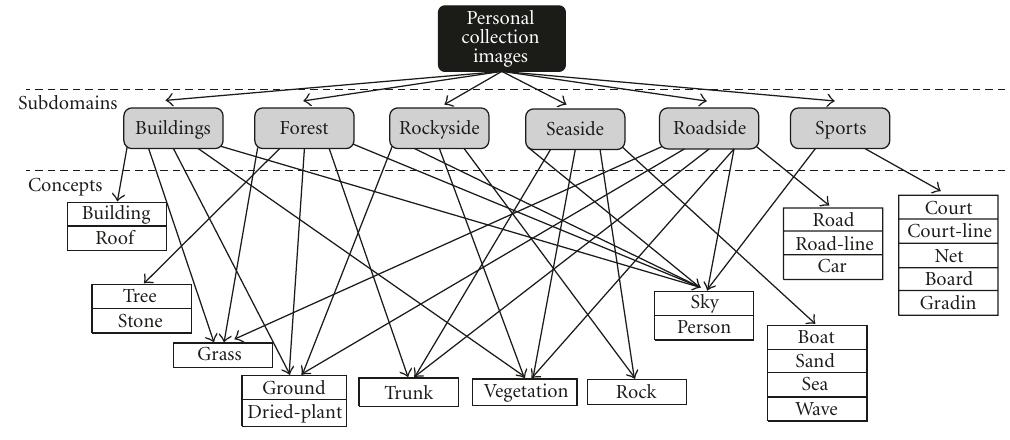
Figure 4: Subdomains and concepts of the ontology developed for the personal collection